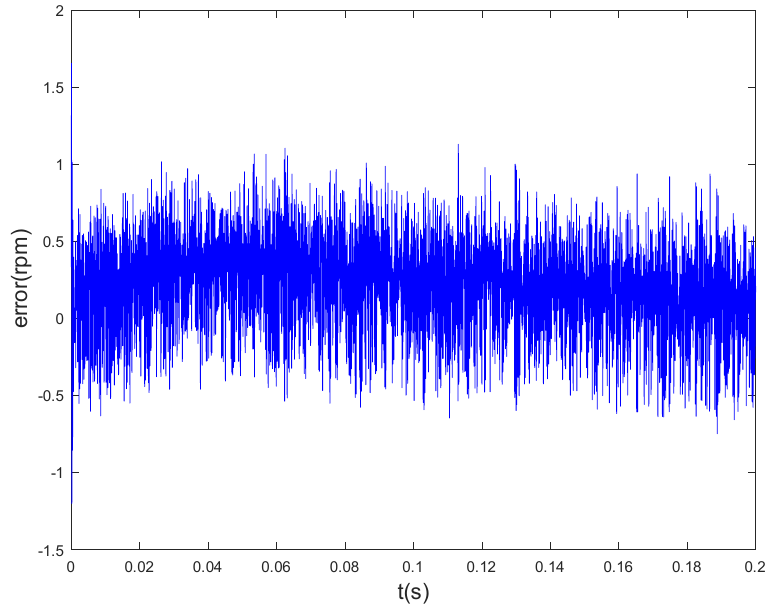
Figure 14. Speed error curve when α = 0.002.